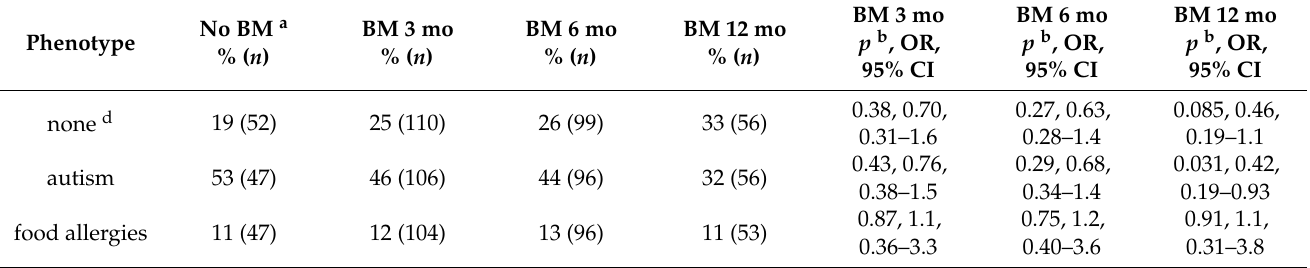
Table 3. Analysis of FXS comorbidities as a function of duration of breast